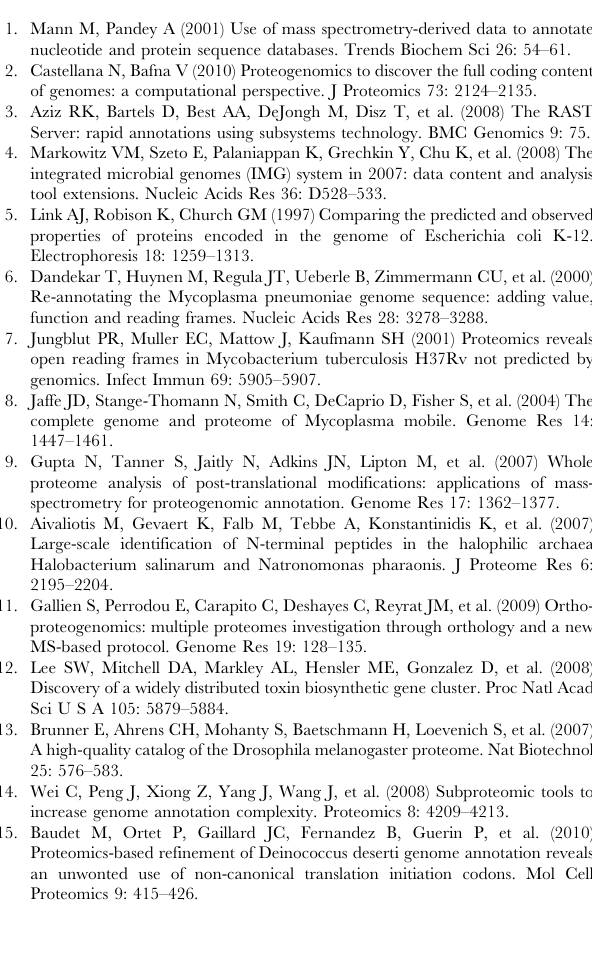
Table S3 Change in conflicted loci according to PSM specificity. For each organism, the number of conflicts (levels 4,5,6) are shown at two different PSM specificity cutoffs, a loose 5e-08 and the default 1e-10. With the loose cutoff there is often a much larger number of conflicted loci, indicating a high false- discovery at the protein